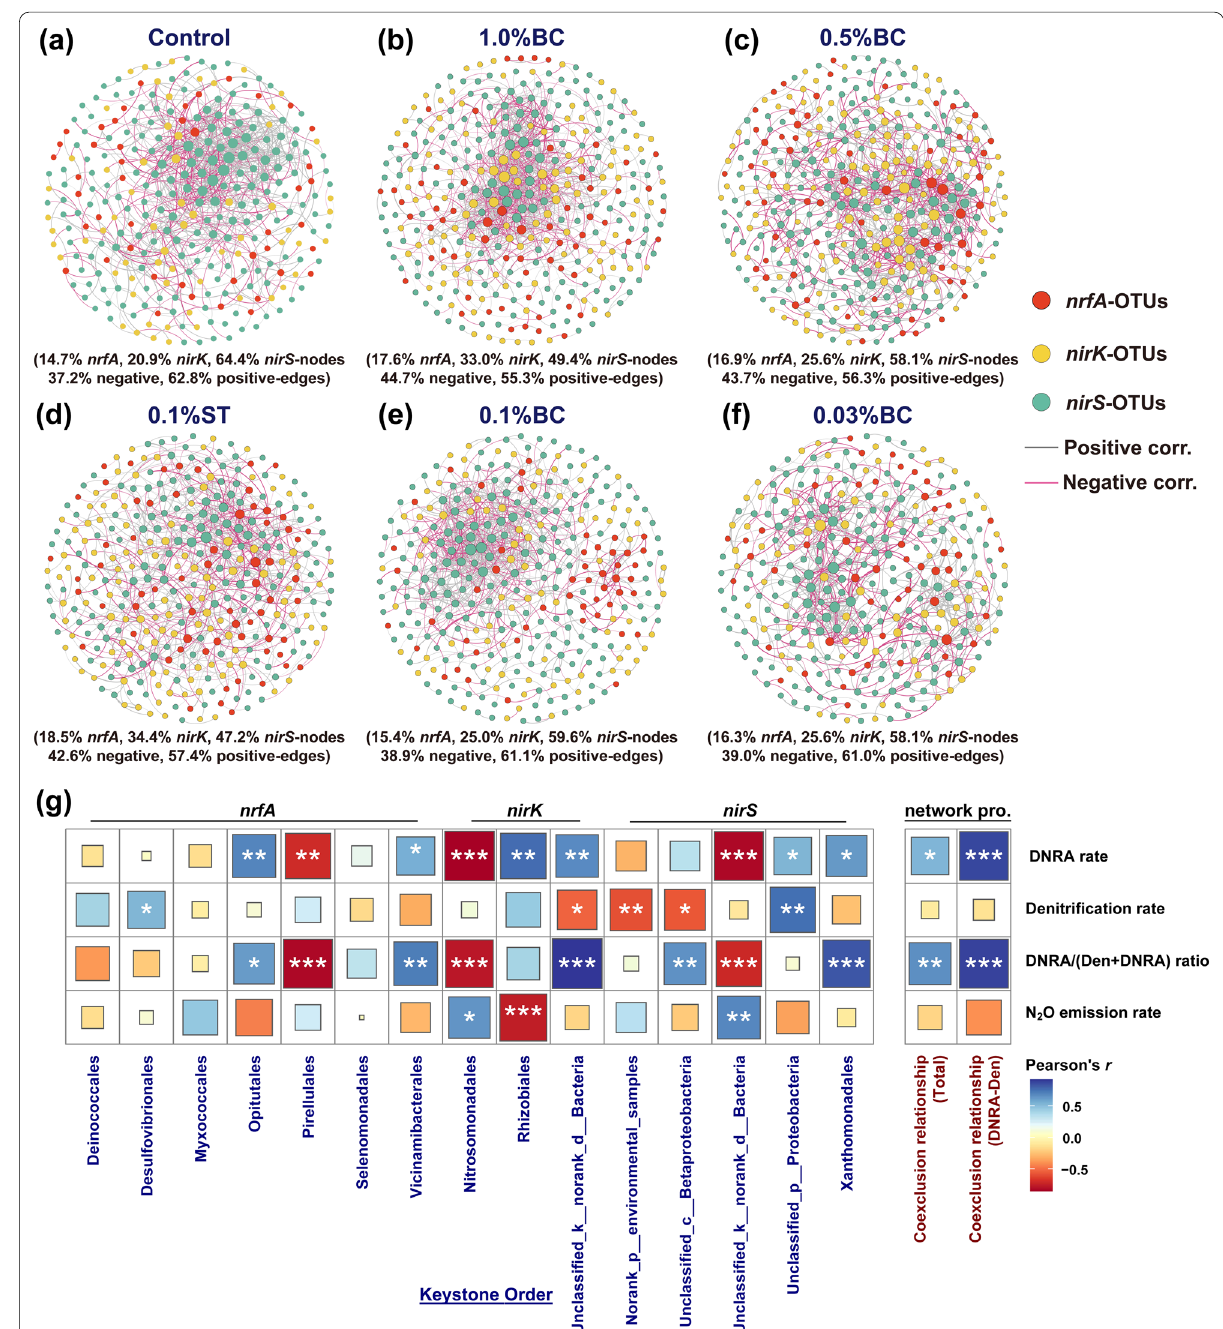
Fig. 4 Co-occurrence network analysis between nirK -, nirS -, and nrfA -encoding nitrate reducer communities (OTU level) in the Control, 0.03%BC, 0.1%BC, 0.5%BC, 1.0%BC, and 0.1%ST treatments. In microbial networks, nodes with different colors represent individual OTUs whose size is positively correlated with the node degree, with red, yellow, and dark green nodes representing nrfA OTUs, nirK OTUs, and nirS OTUs, respectively; edges represent significant Sparcc correlations (| correlation| > 0.60 and P < 0.01), of which the color indicates the interactions of positive (gray) and negative (red) between the OTUs ( a ‒ f ). Pearson correlations between the relative abundance of keystone orders encoded by nrfA , nirK , and nirS genes (nodes within modular hubs, network hubs, or connectors) and N transformation rates [Denitrification, DNRA, N 2 O emission, and DNRA/ (Den DNRA) ratio], as well as properties of the network among biochar amendment treatments ( g ). Coexclusion relationship (Total): ratios + of negative and positive correlations among DNRA bacteria and denitrifiers [ nrfA - nirK ( S ), nrfA - nrfA , and nirK ( S )- nirK ( S )]; Coexclusion relationship (DNRA-Den): ratios of negative and positive correlations between DNRA bacteria and denitrifiers [ nrfA - nirK ( S